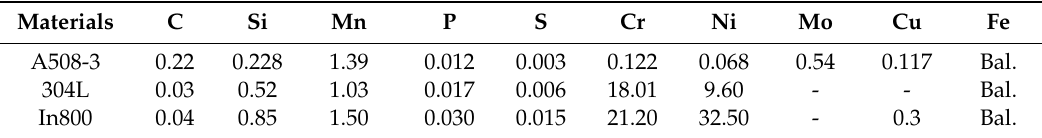
Table 1. The elemental composition of A508-3 steel (A508-3), 304L stainless steel (304L) and Incoloy 800 alloy